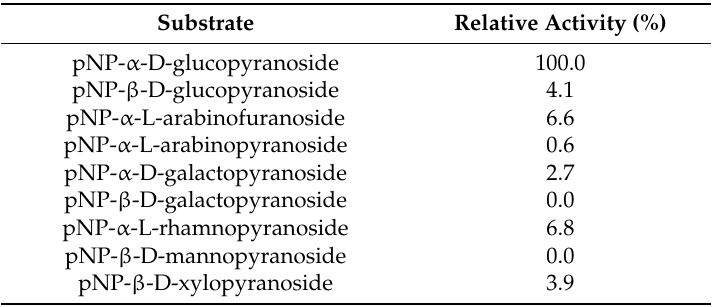
Table 3. Substrate specificity of recombinant GSJ on p NP derivatives.